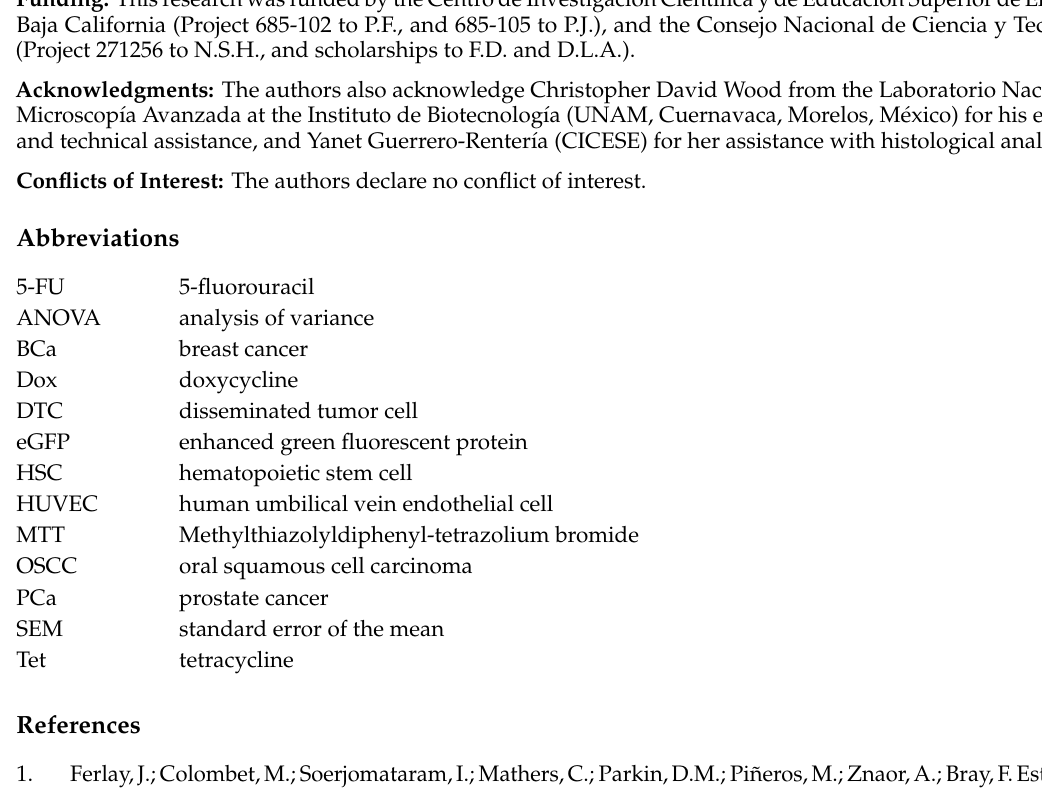
Figure S1: High expression of TIE2 in the primary tumor of breast cancer patients is associated with an increased time to the relapse, Figure S2: Selection of MCF-7 TIE2 tet and 4T1 TIE2 tet cells with inducible expression of TIE2, Figure S3: Doxycycline does not a ff ect the growth of mammary fat pad tumors growth or the formation of osteolysis in